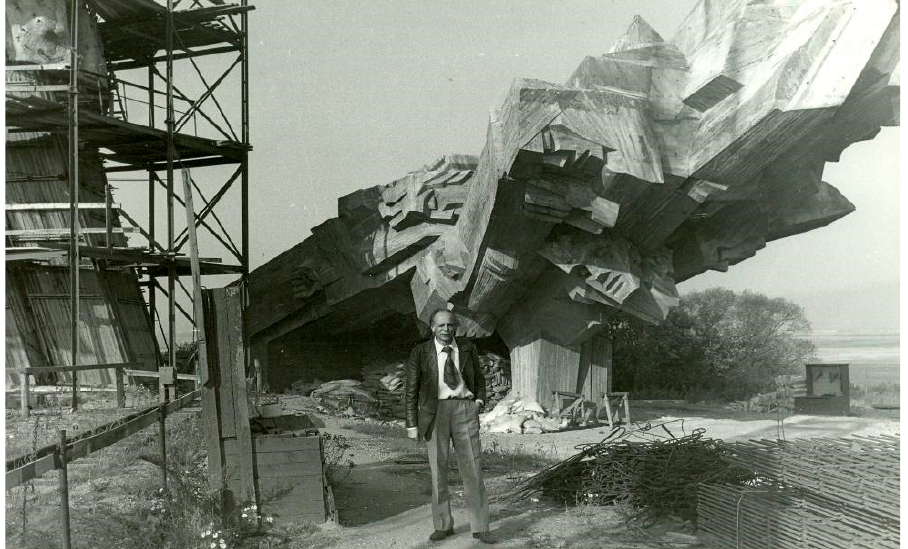
Figure 4. Architect V. Vielius during the process of the construction of the Ninth Fort monument in Kaunas, the late 1970s. From the Kaunas Ninth Fort museum.